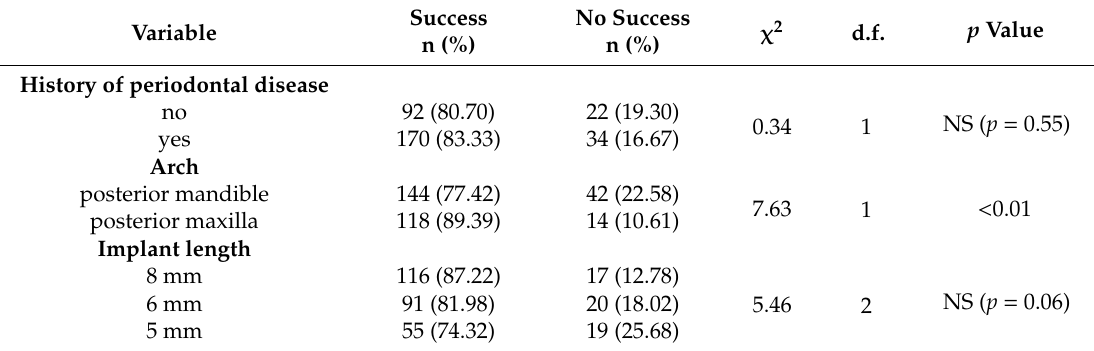
Table 8. Implant success according to PP / NPP-groups, length-groups and arch-groups. For all variables, values are presented as n (%); NS = not statistically significant; d.f. = degrees of freedom.